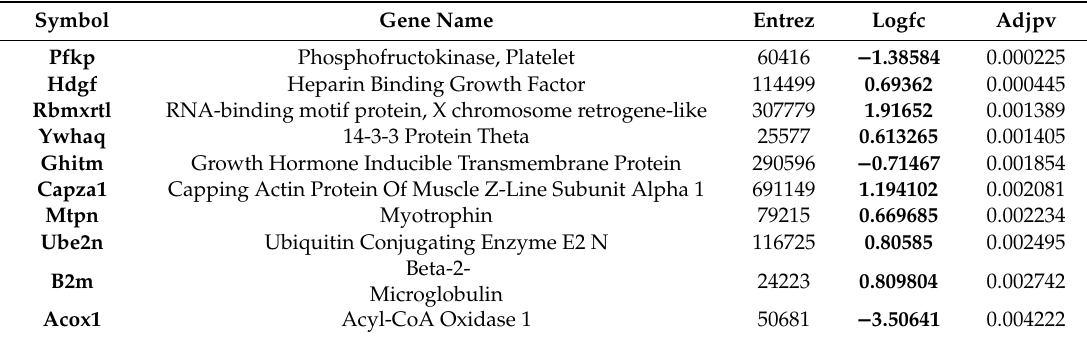
Table 2. Top 10 di ff erentially regulated proteins in